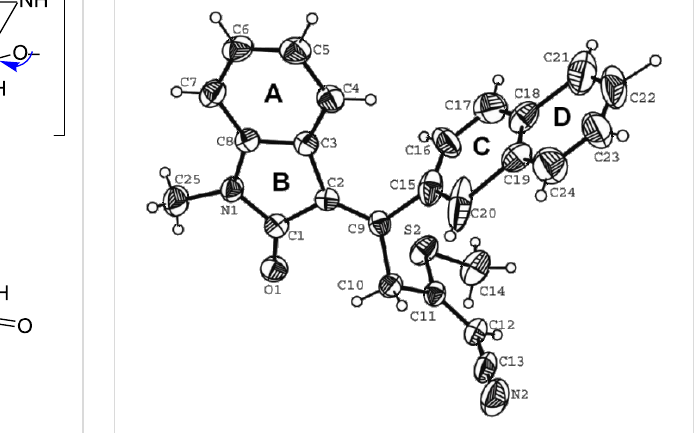
Scheme 2: A plausible mechanism for the formation of 1-aryl-3- methylthio-5 H -dibenzo[ d,f ][1,3]diazepin-6(7 H )-ones.